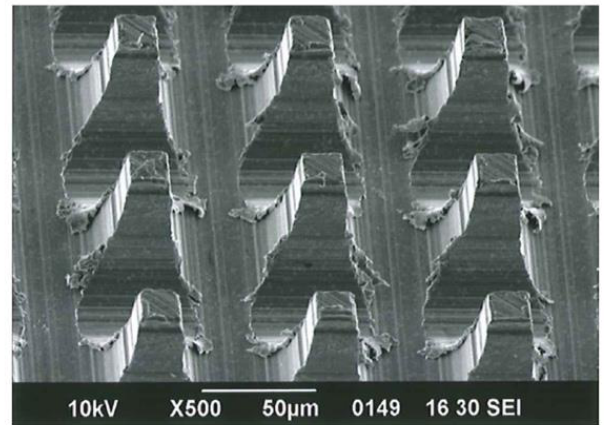
Figure 1. Scanning electron microscopy image of the microarrayed pin needle punch structure (JSM-6390LV, JEOL, Tokyo, Japan; scale bar represents 50 μm).